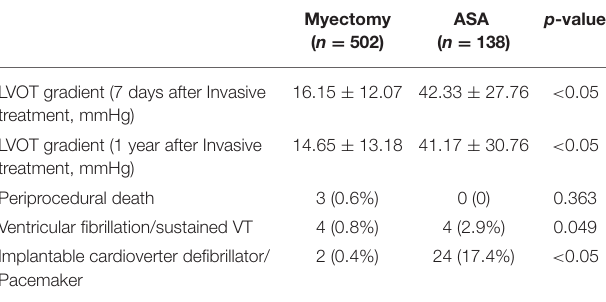
TABLE 2 | Periprocedural complications (30 days) and LVOT gradient changes after invasive treatment.